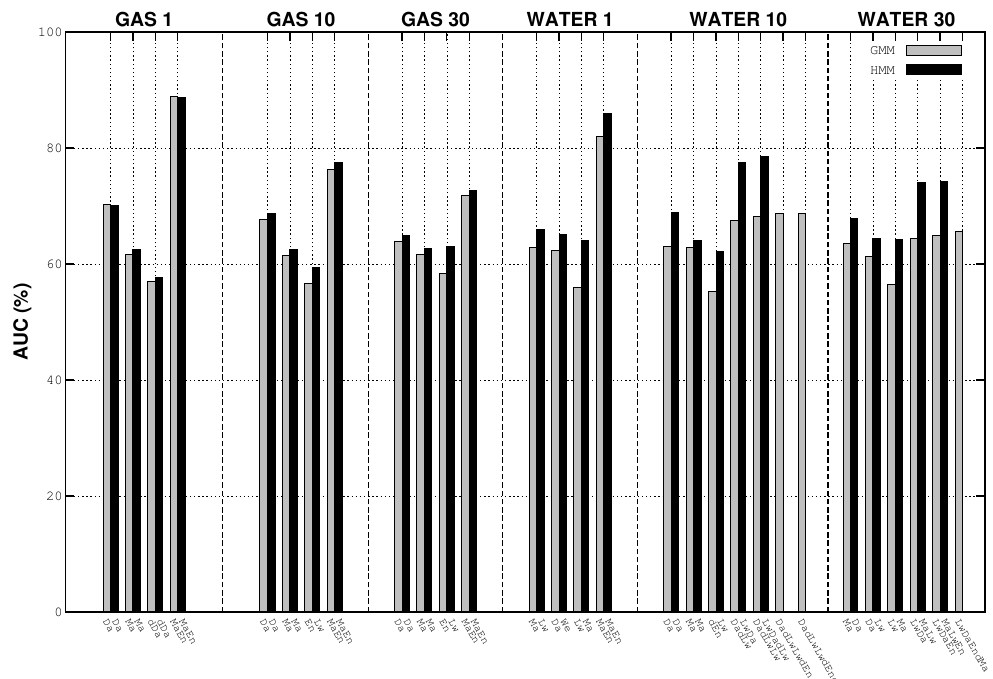
Figure 3. Feature selection steps and corresponding features’ combination until the achievement of the best result for the AMPds datasets. In the x-axis are reported the corresponding best features’ combinations for both GMM and HMM.